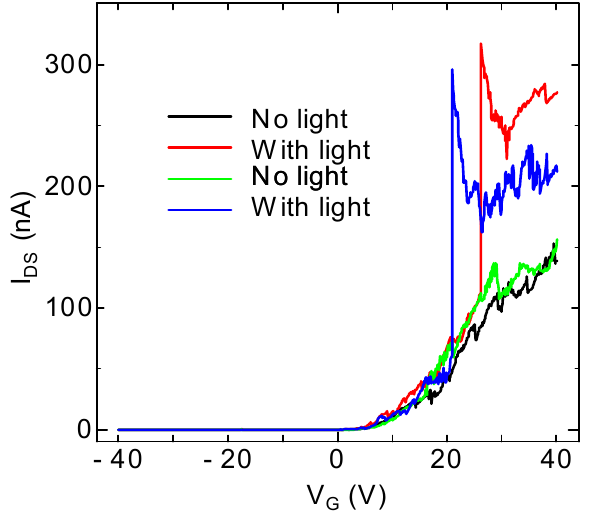
= 0.5 V) measured at 10 K for an n -type C DS = 21 V and 26 G